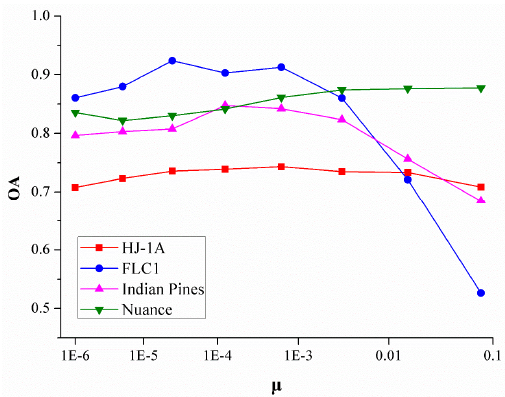
Figure 7. Comparison of the performance of the proposed method with different penalty parameter settings for all our experiments.